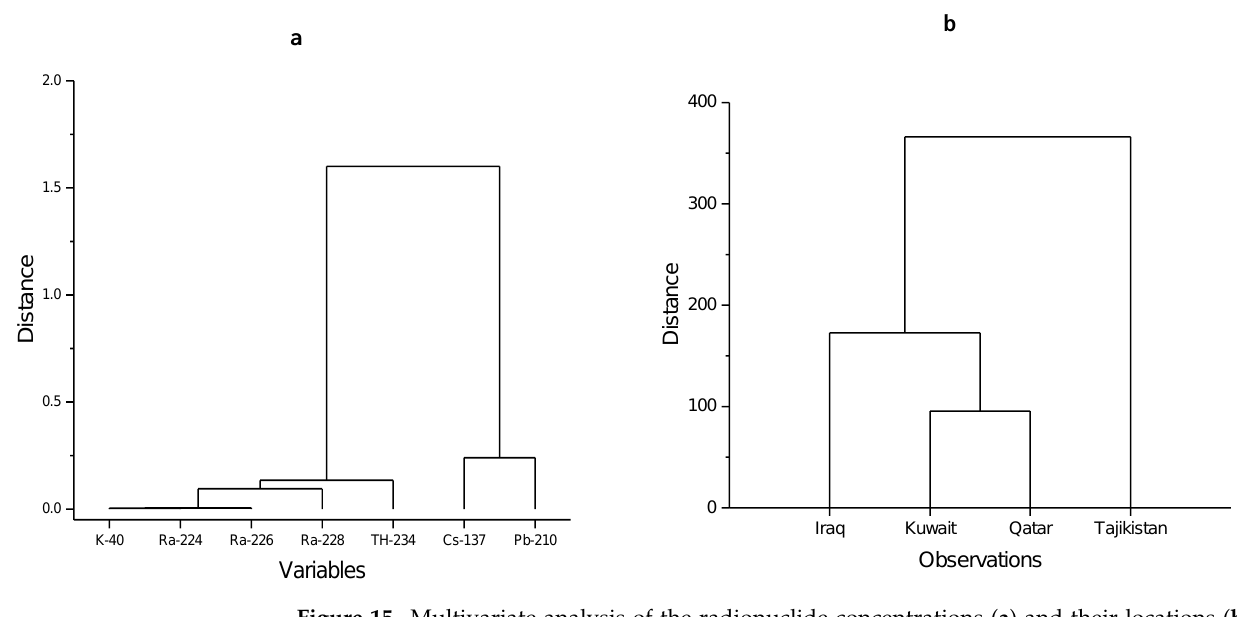
Figure 15. Multivariate analysis of the radionuclide concentrations ( a ) and their locations ( b ) in dust samples.